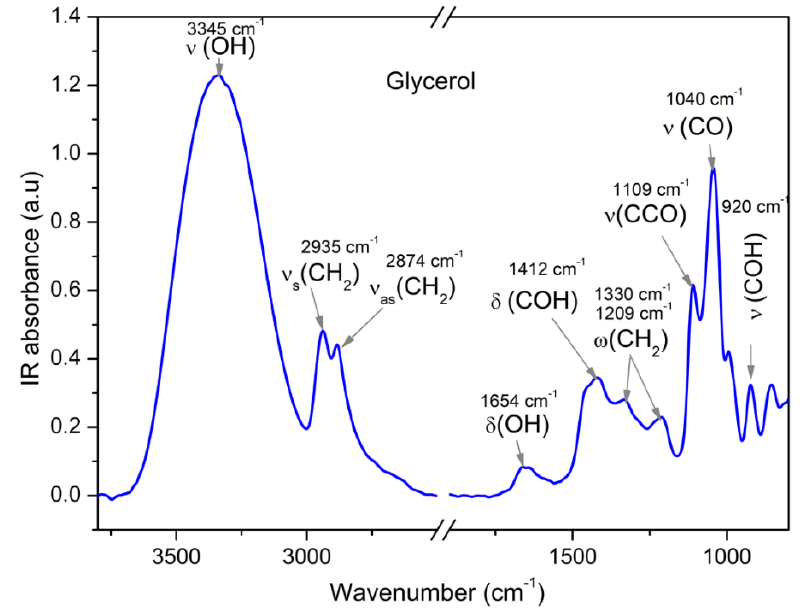
Figure 2. Characteristic IR-absorption bands [13] of glycerol, stretching vibration υ (OH), symmetric υ s (CH 2 ) and asymmetric stretching vibration υ as (CH 2 ), bending vibrations δ (OH) and δ (COH), and wagging vibration ω (CH 2 ) and stretching vibrations υ (CCO), υ (CO), and υ (COH).